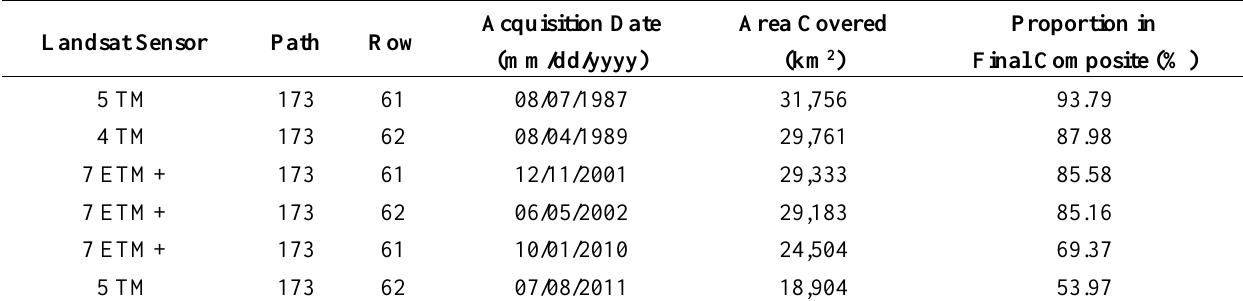
Table 1. Primary Landsat images acquired for land cover classification in Lake Kivu region. Landsat Sensor Path Row